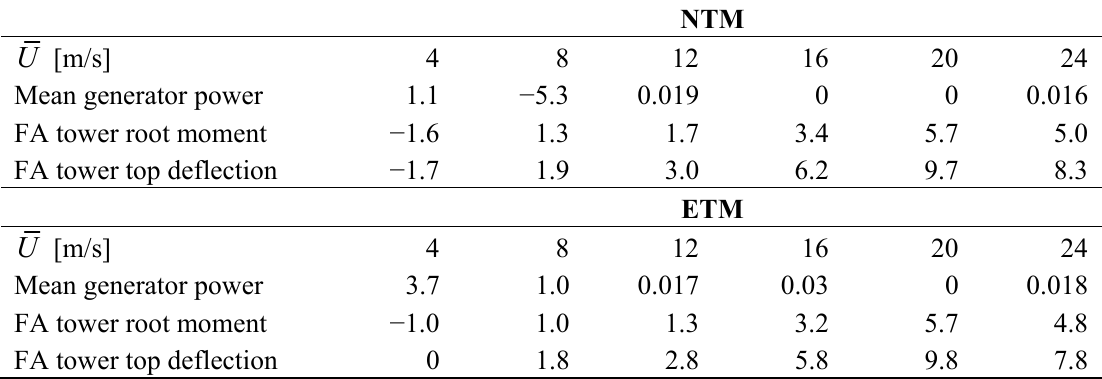
Table 6. Reduction percentage of mean power and load on tower using DTEF control (%).